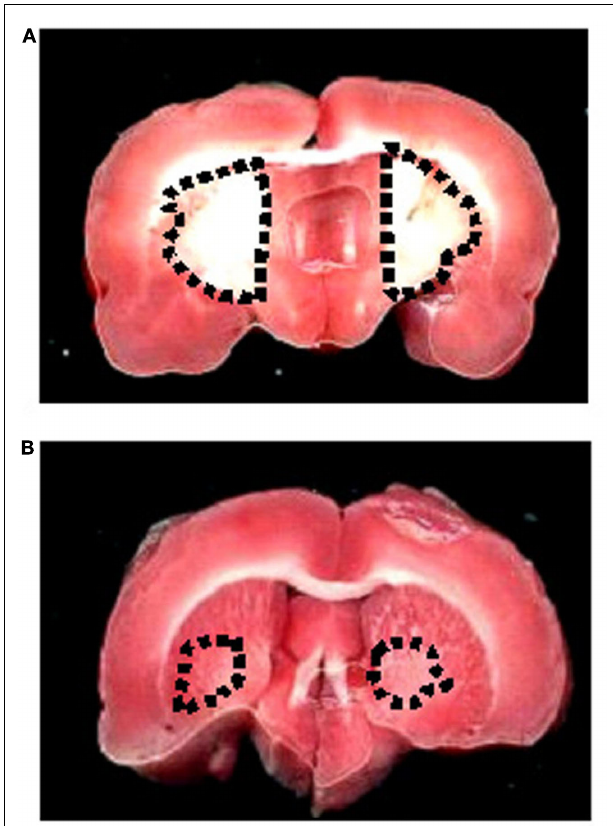
FIGURE 5 |TTC staining of coronal brain slice from a rat submitted to BCCAO and reperfusion. The lesion in the striatum is outlined by the dashed black line (A) .TTC staining of coronal brain slice from a rat treated with highest dose quercetin (5.0mg/kg b.w.; subgroup Q 3 ) and submitted to BCCAO and reperfusion, where there was reduced injury (B)